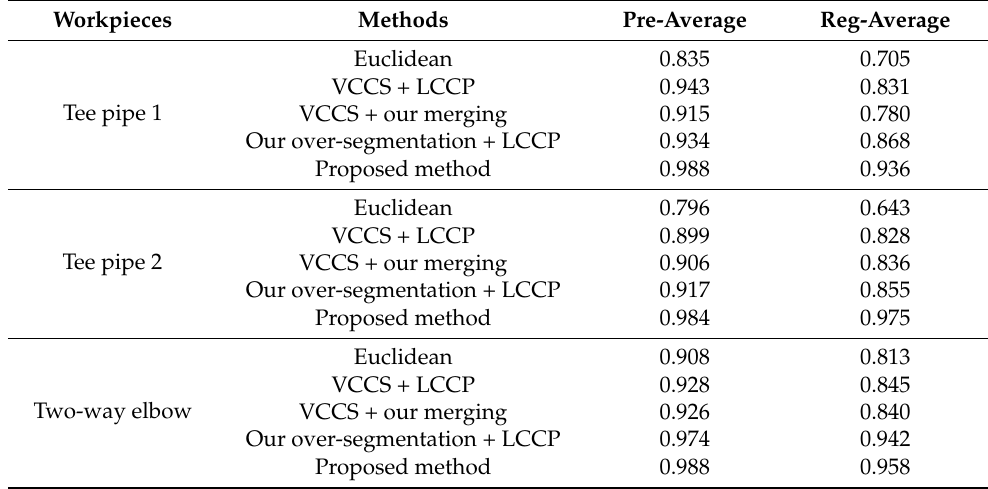
Table 3. The comparison of performance.